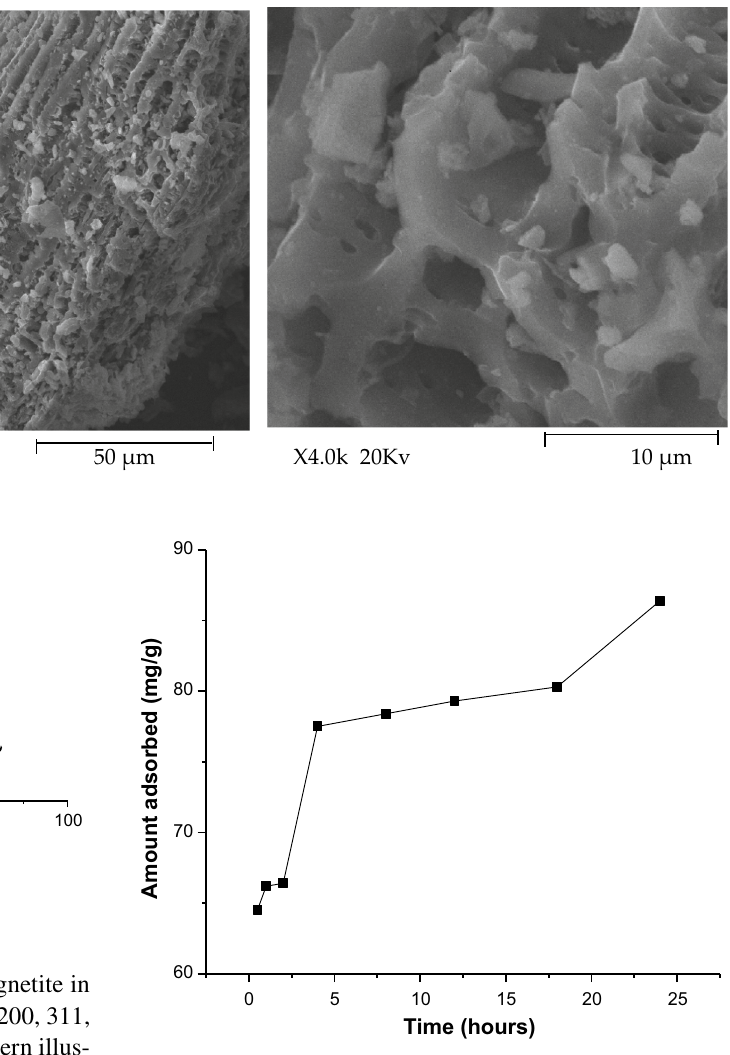
Fig. 4 Effect of contact time on adsorption of Pb 2+ ions on WM- Fe 3 O